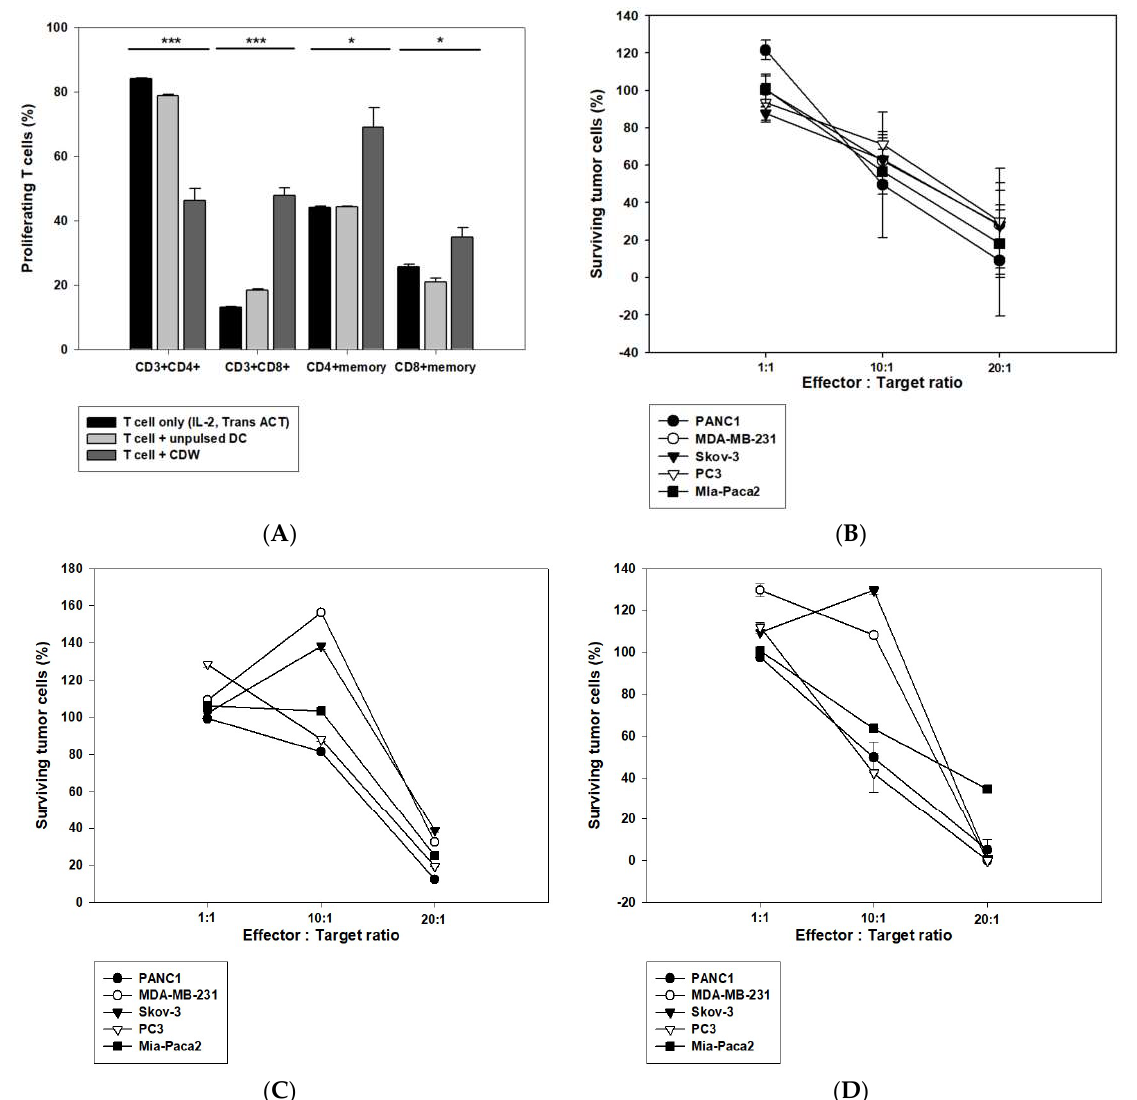
Figure 5. CDW increases CD8+ T cells to promote cytotoxicity against cancer cells. Effect of CDW on T cell response assessed via CTL. IL-2 and Trans-Act are T cell stimulators and were used to stimulate T cells. The activated T cells were co-cultured with DC for the first induction, which lasts for seven days and the second induction which extends to 10 days. The changes in the T cell subtype were analyzed via flow cytometry ( A ). The T cells cultured for 10–14 days were co-cultured with cancer cells expressing WT1 according to appropriate ratios in a 96-well plate. Post-72 h, the survival rate of cancer cells was analyzed using CCK8 ( B – D ). T cells induced by CDW group ( B ). T cell only group (activated IL-2 and Trans ACT) ( C ). T cells induced by unpulsed DC group ( D ). * p < 0.05, *** p < 0.001.